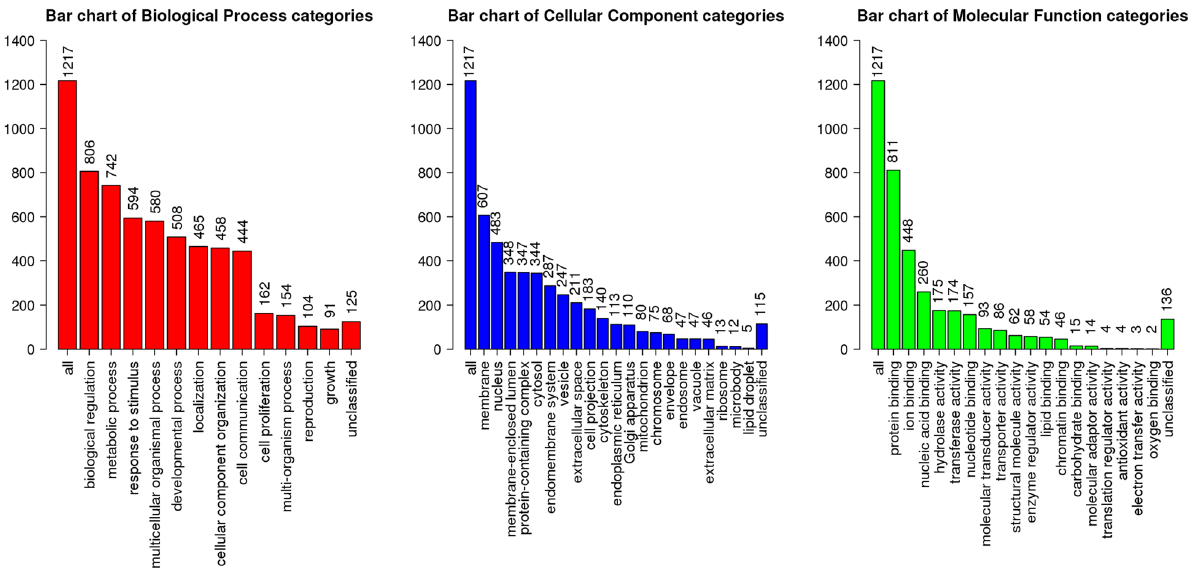
Figure 8. Selective sweep gene GO analysis at the top 1% threshold, from left to right are biological processes, cell composition and molecular